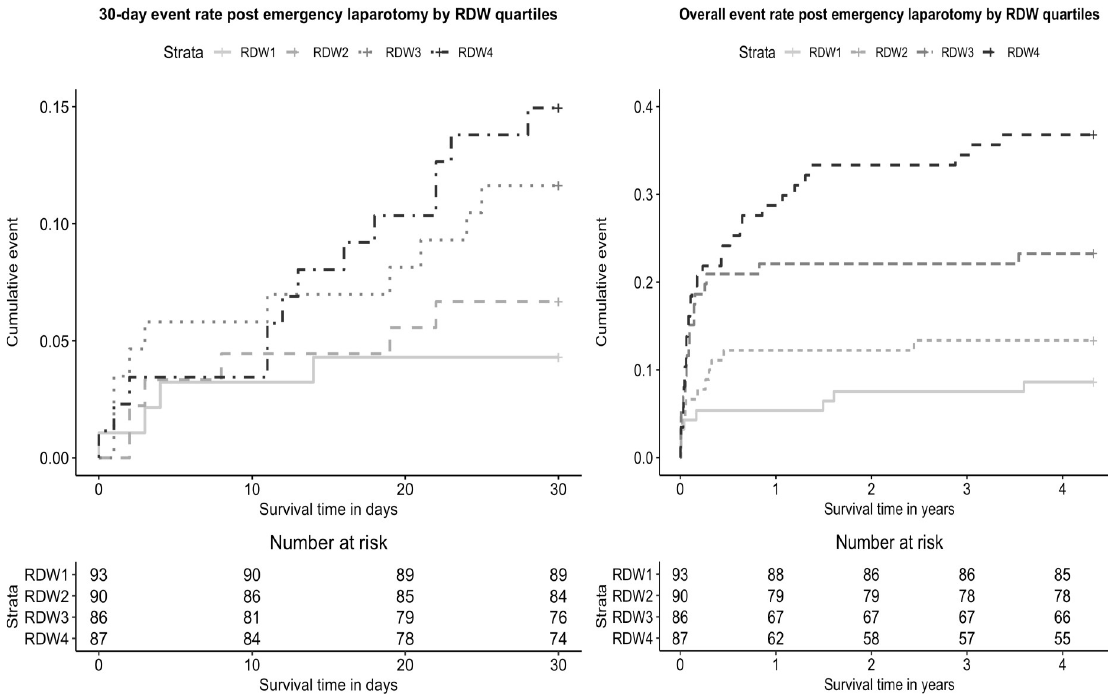
Fig 2. Cumulative mortality rate plots for 30-day and overall mortality post emergency laparotomy by RDW quartiles. The log-rank test was significant for the total follow-up period χ 2 (log-rank) = 25.5, d.f. = 3, p < 0.001 (d.f. degrees of freedom). For 30-day mortality the survival lines cross and the log-rank test is unlikely to detect a difference and should not be used for methodological reasons [21].